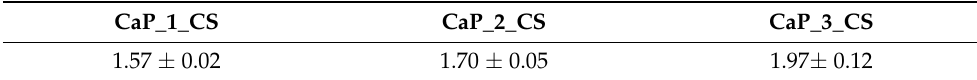
Table 6. EDX Ca/P ratios for the CaP_CS